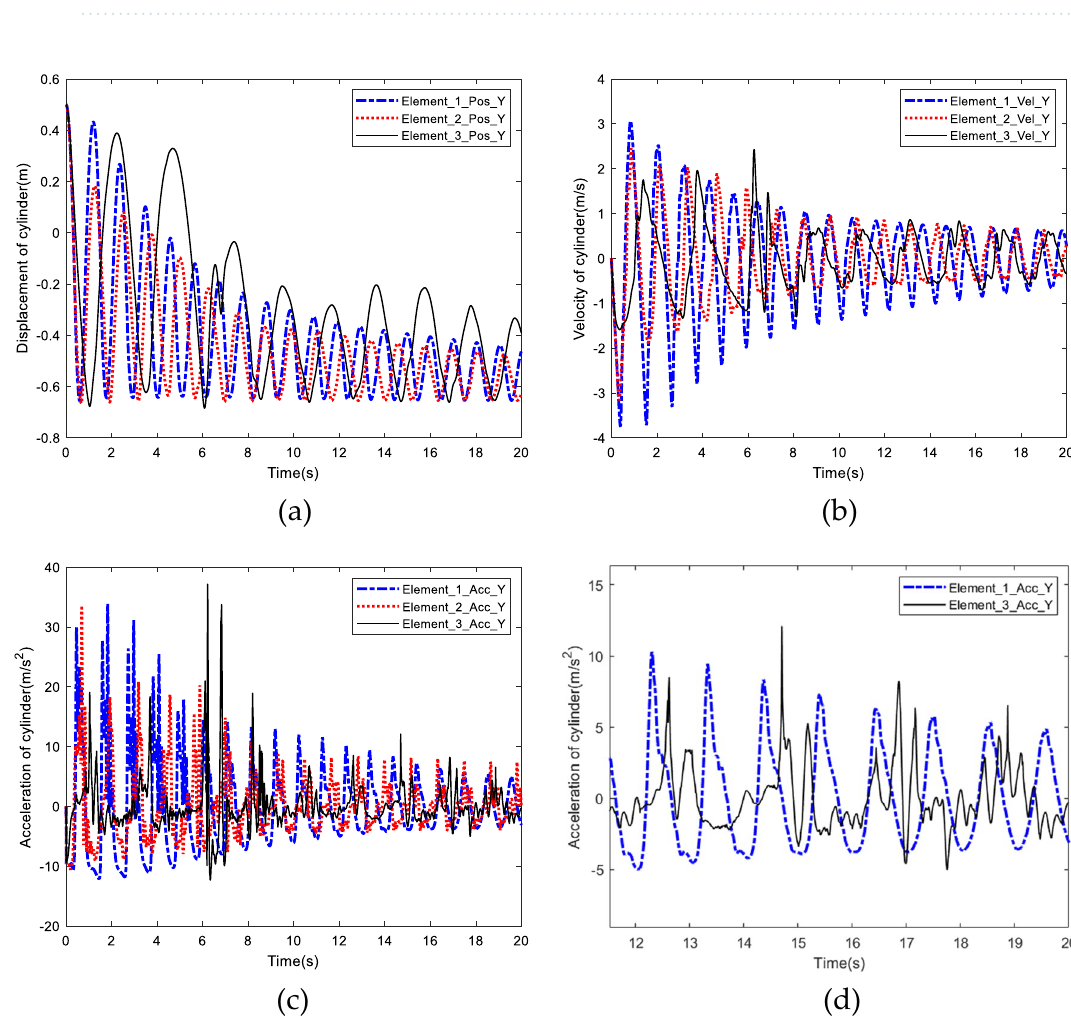
Figure 13. Comparison of different element length. ( a ) Comparison of displacement. ( b ) Comparison of velocity. ( c ) Comparison of acceleration. ( d ) Enlarged view of acceleration comparison between Element_1 and